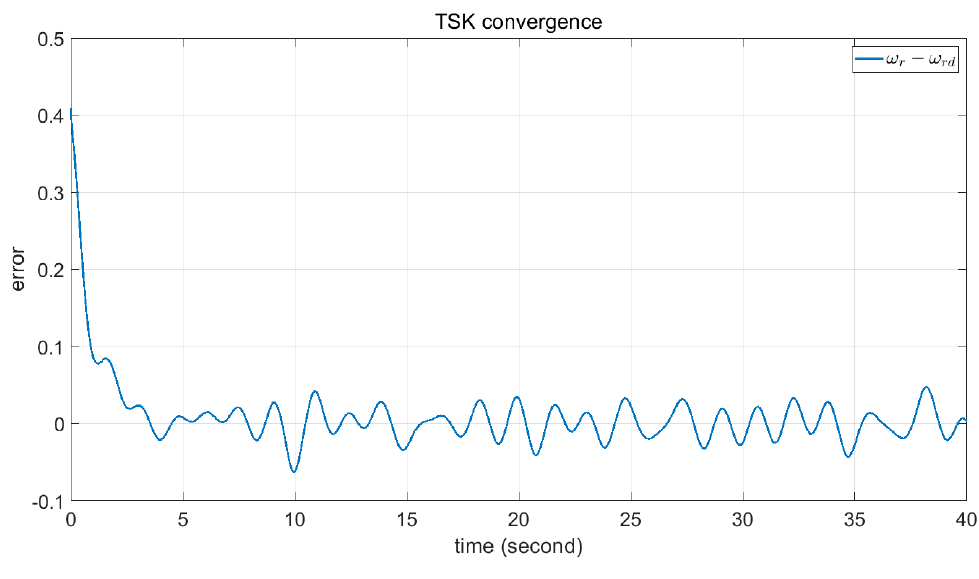
Figure 15. Convergence of the fuzzy TSK.